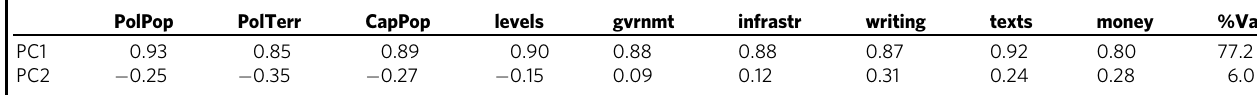
Table 1 Loadings of the nine complexity components onto PC1 and PC2, and the percentage of variance of the full dataset explained by each PC. We present our calculations which differ very slightly from those presented in ref. 22 .